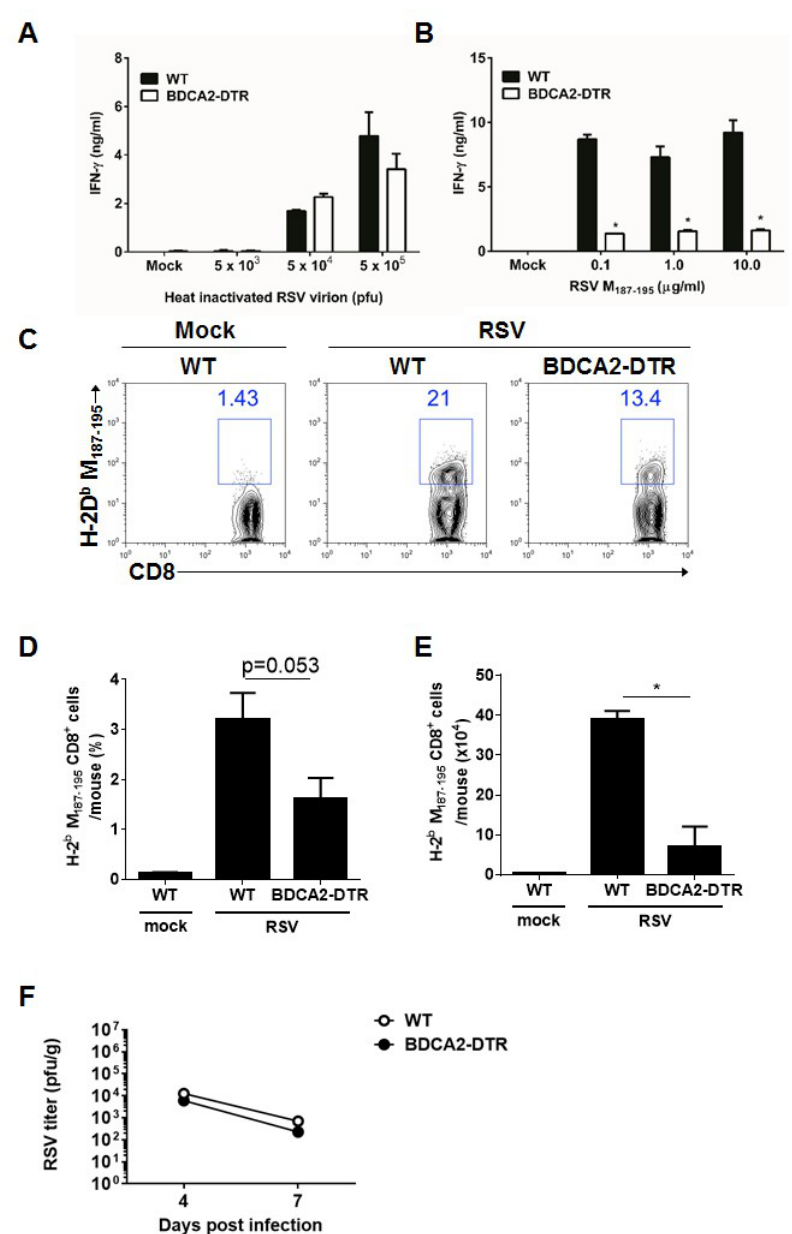
Figure 4. Plasmacytoid dendritic cells are needed for proper cytotoxic T cell responses to RSV infection, while pDC depletion does not alter Th1 induction and the virus titers in RSV-infected mice.